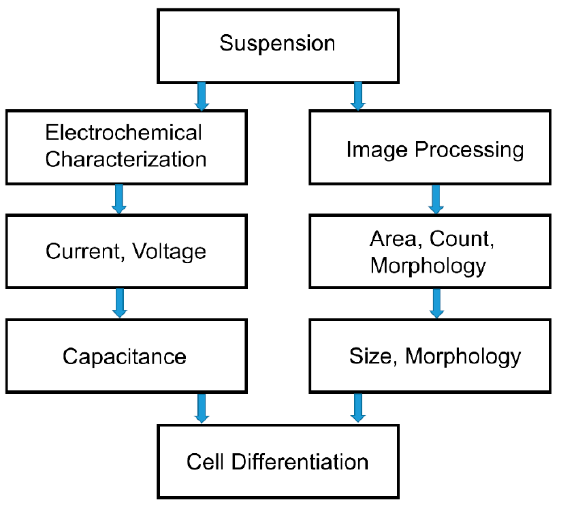
Figure 2. The two approaches for innate immune cell differentiation.